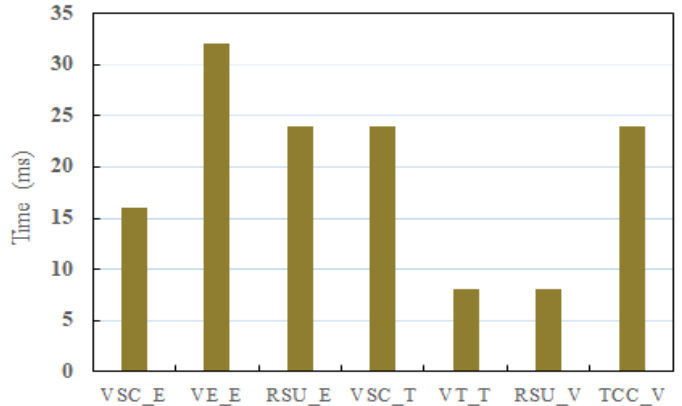
Figure 2. The overhead comparison among different phases of our